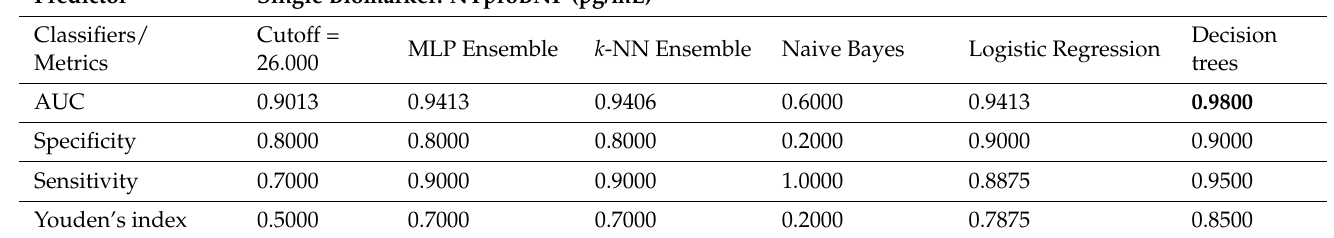
Table 4. The diagnostic performance of the six classifiers for predicting CRS by using single predictive variable: biomarker NTproBNP (pg/mL). Metrics of performance are: AUC, specificity, sensitivity, and Youden’s index.